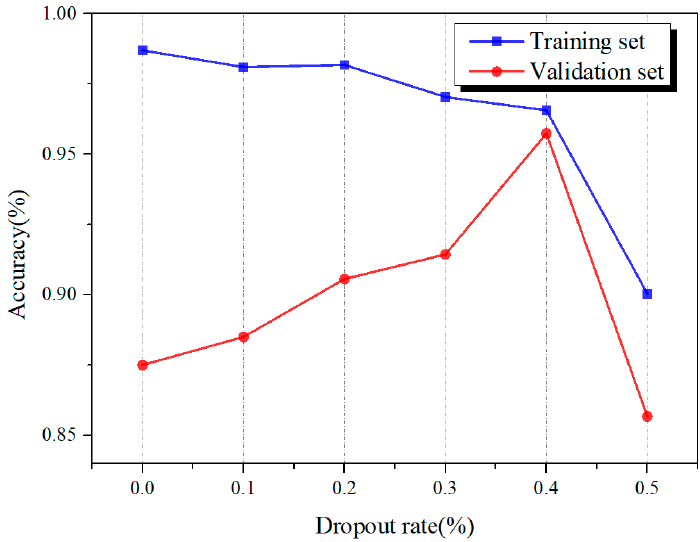
Figure 16. Comparison of the training results of CNN on training set and validation set under different dropout rates.